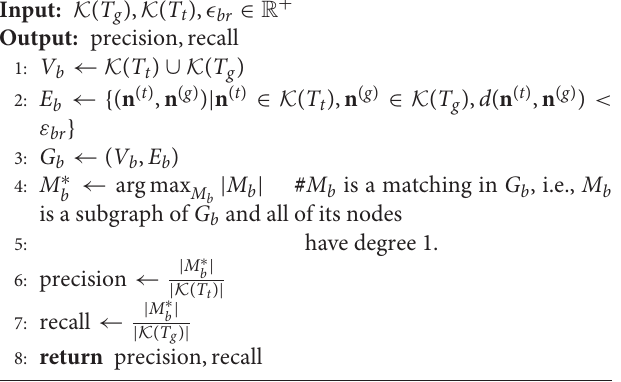
Algorithm 3: Critical node metric.